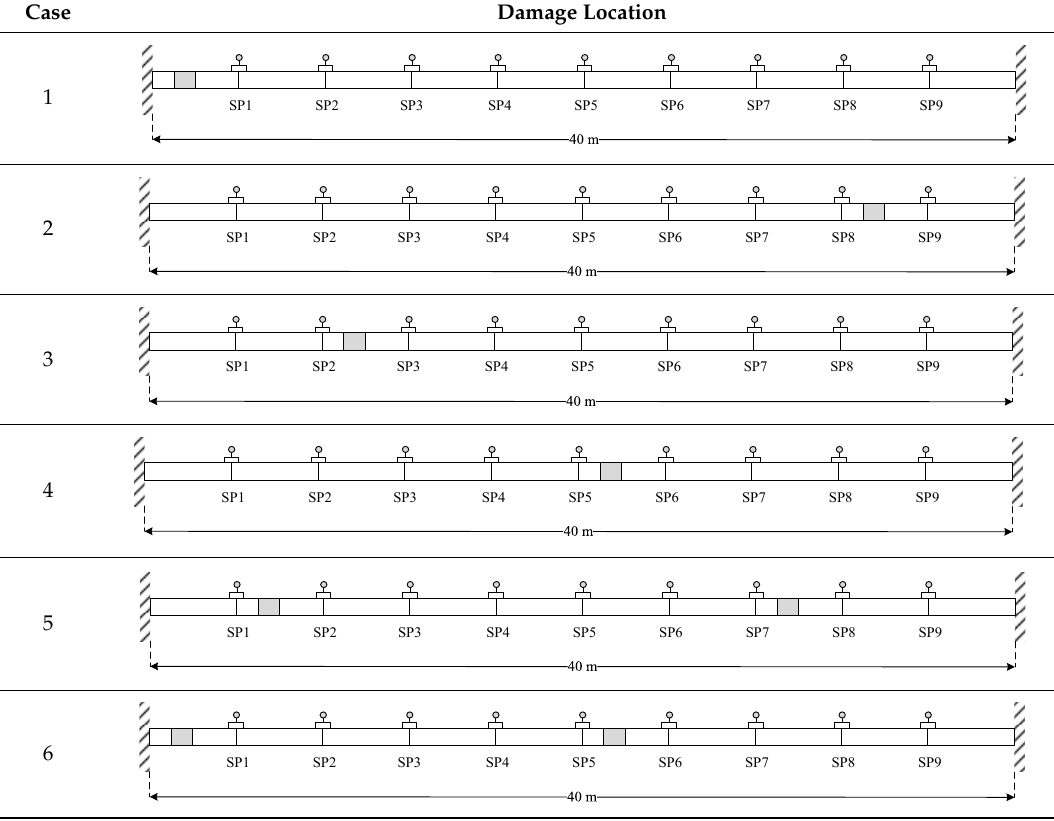
Figure 20. Level 2 damage indicator for Case 1. Figure 21. Level 2 damage indicator for Case 2. Figure 22. Level 2 damage indicator for Case